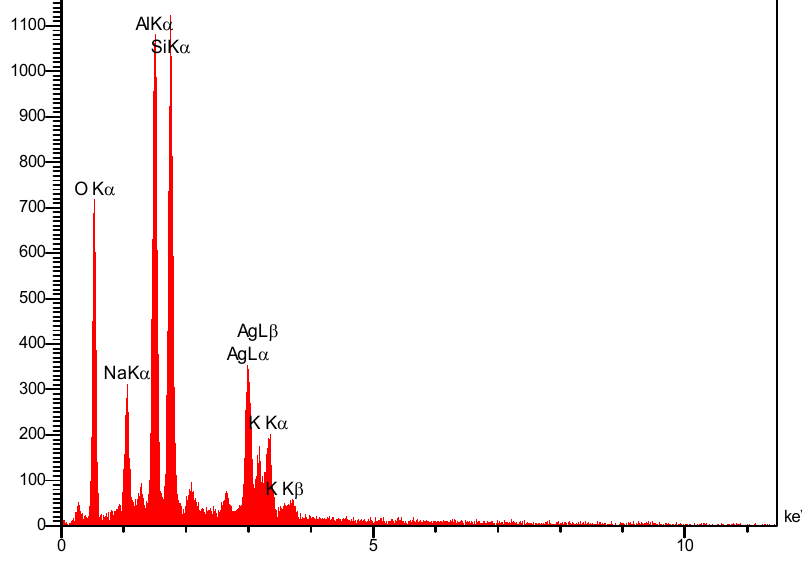
Fig. 6. FE-SEM image of (a) Zeolite 13Xand (b) Ag NPs/Zeolite 13X nanocomposites Fig.6 FE-SEM image of (a) Zeolite 13Xand (b) Ag NPs/Zeolite 13X nanocomposites